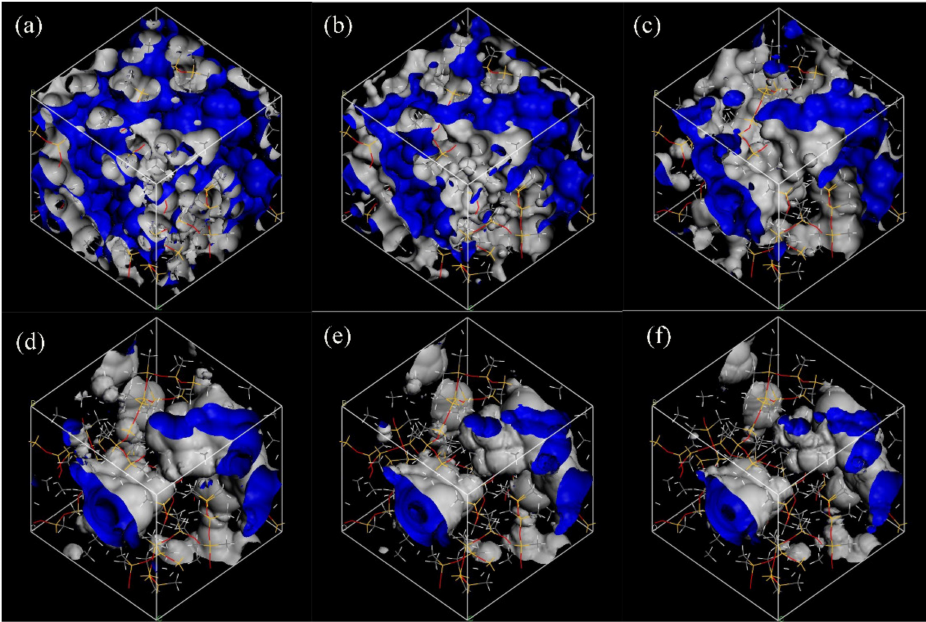
Figure 2. Accessible spaces determined by setting different Connolly radiuses for the probes: ( a ) 0 Å,